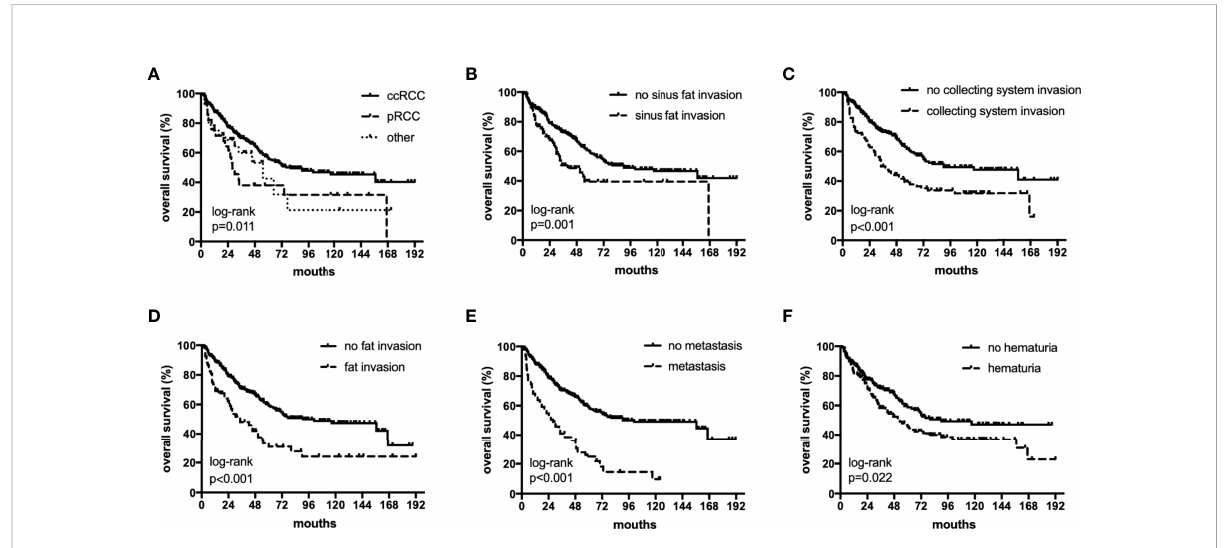
FIGURE 1 The subgroup OS rates of histology (A) , sinus fat invasion (B) , perioperative hematuria (C) , collecting system invasion (D) , fat invasion (E) , and distant metastasis (F)